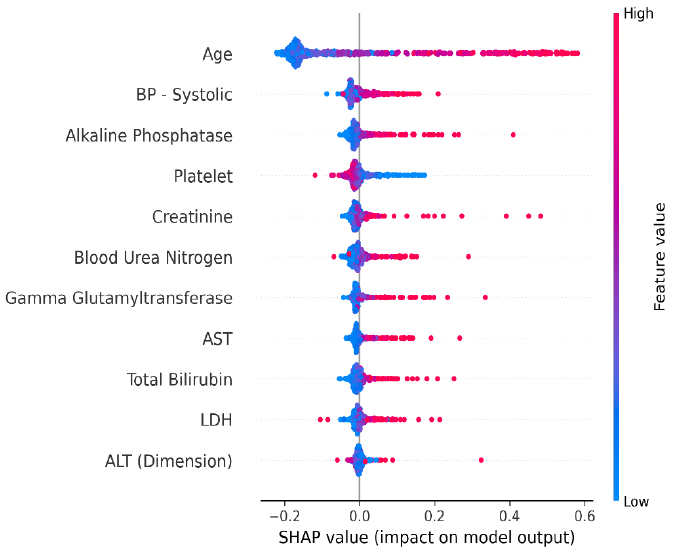
Figure 5. Shapely values using the ET model.